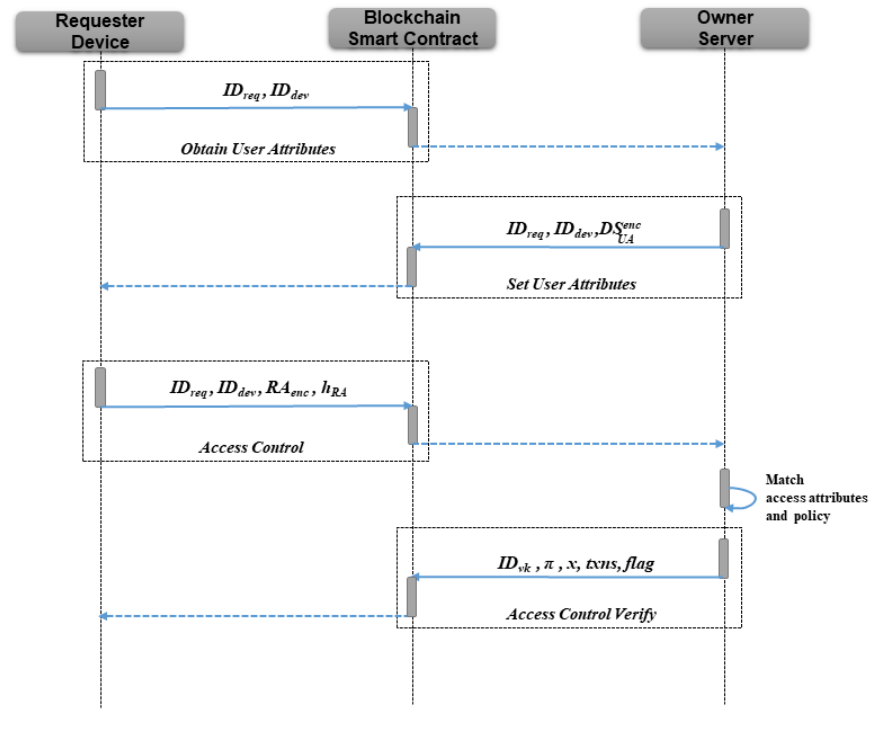
Figure 5. Procedure of the access control authorization phase. Protocol 5. Set User